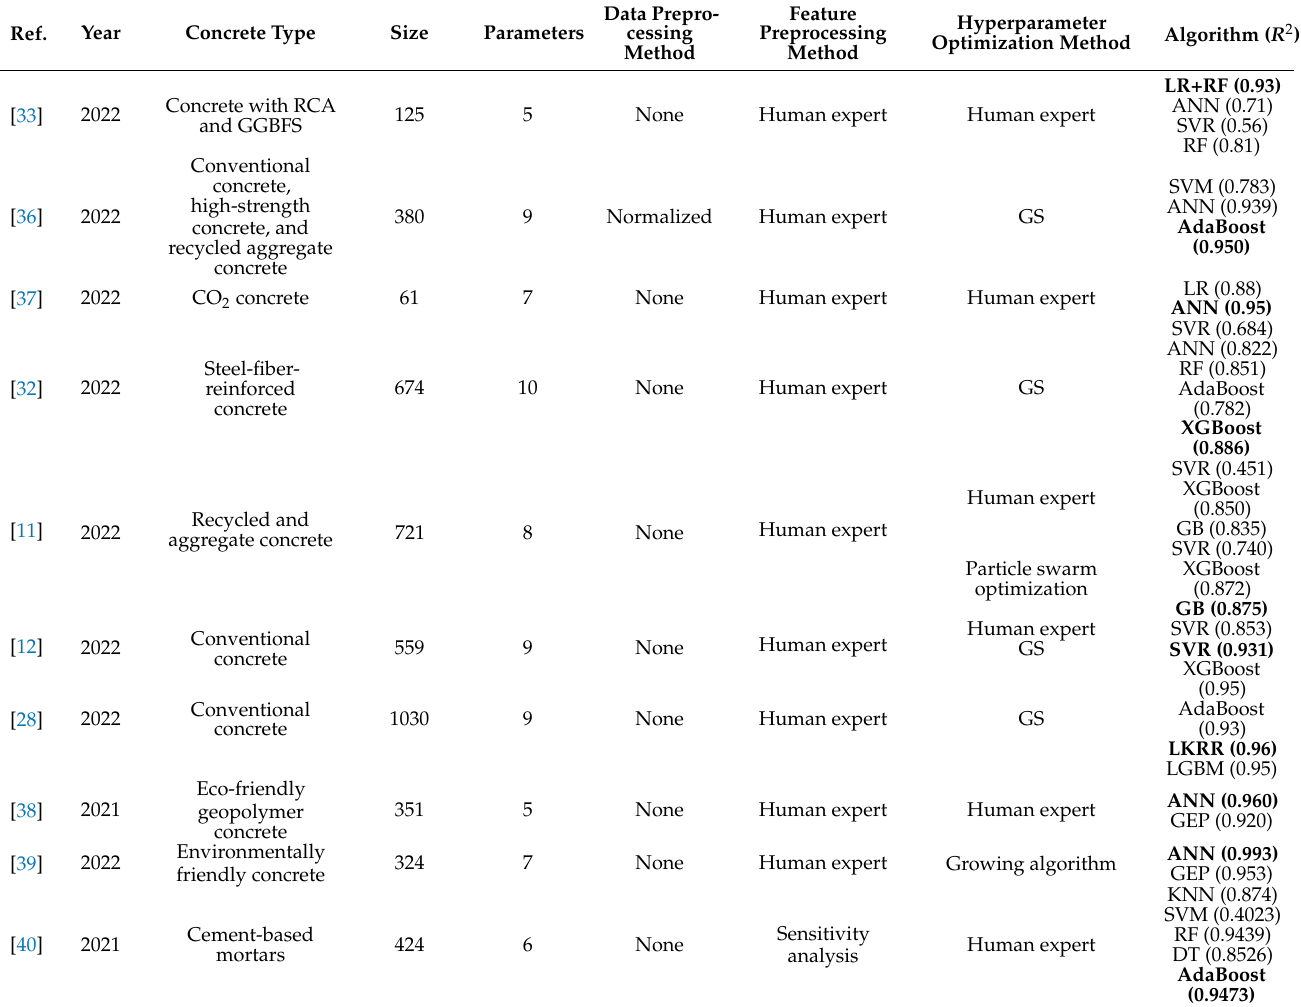
Table 1. Representative studies on compressive strength prediction using ML